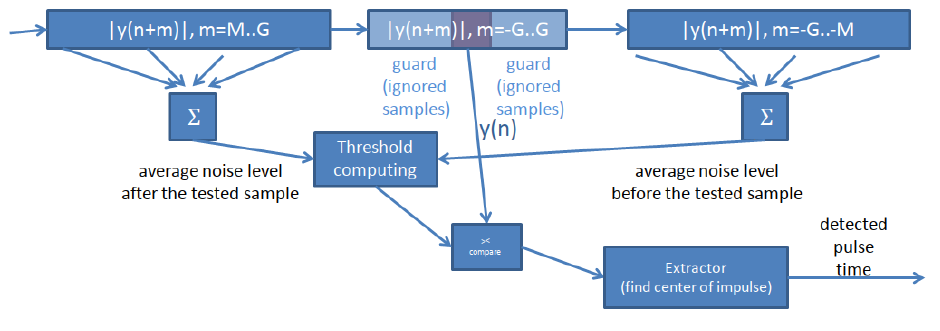
Figure 7. CFAR operation